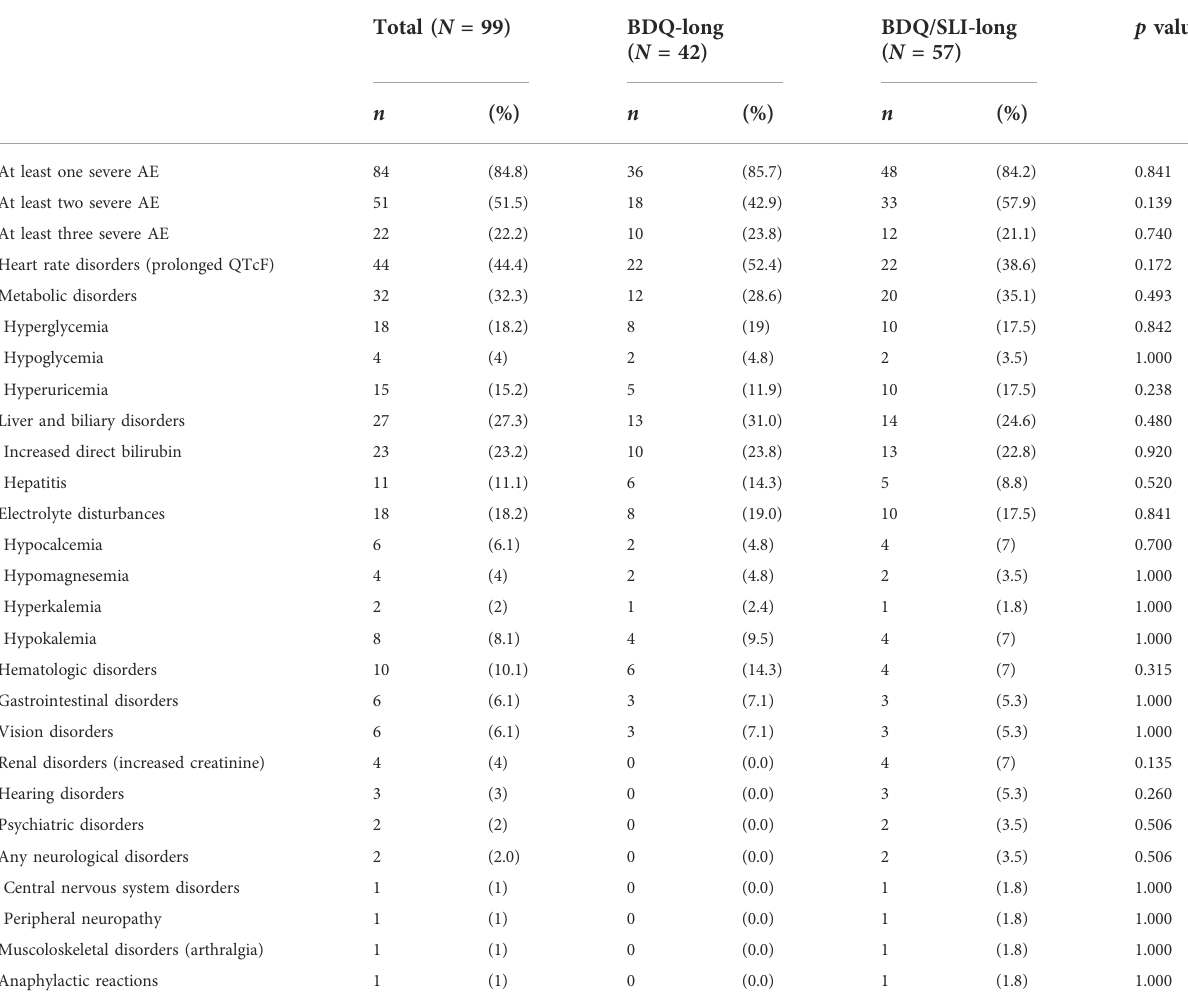
TABLE 3 Number of patients with severe AE by